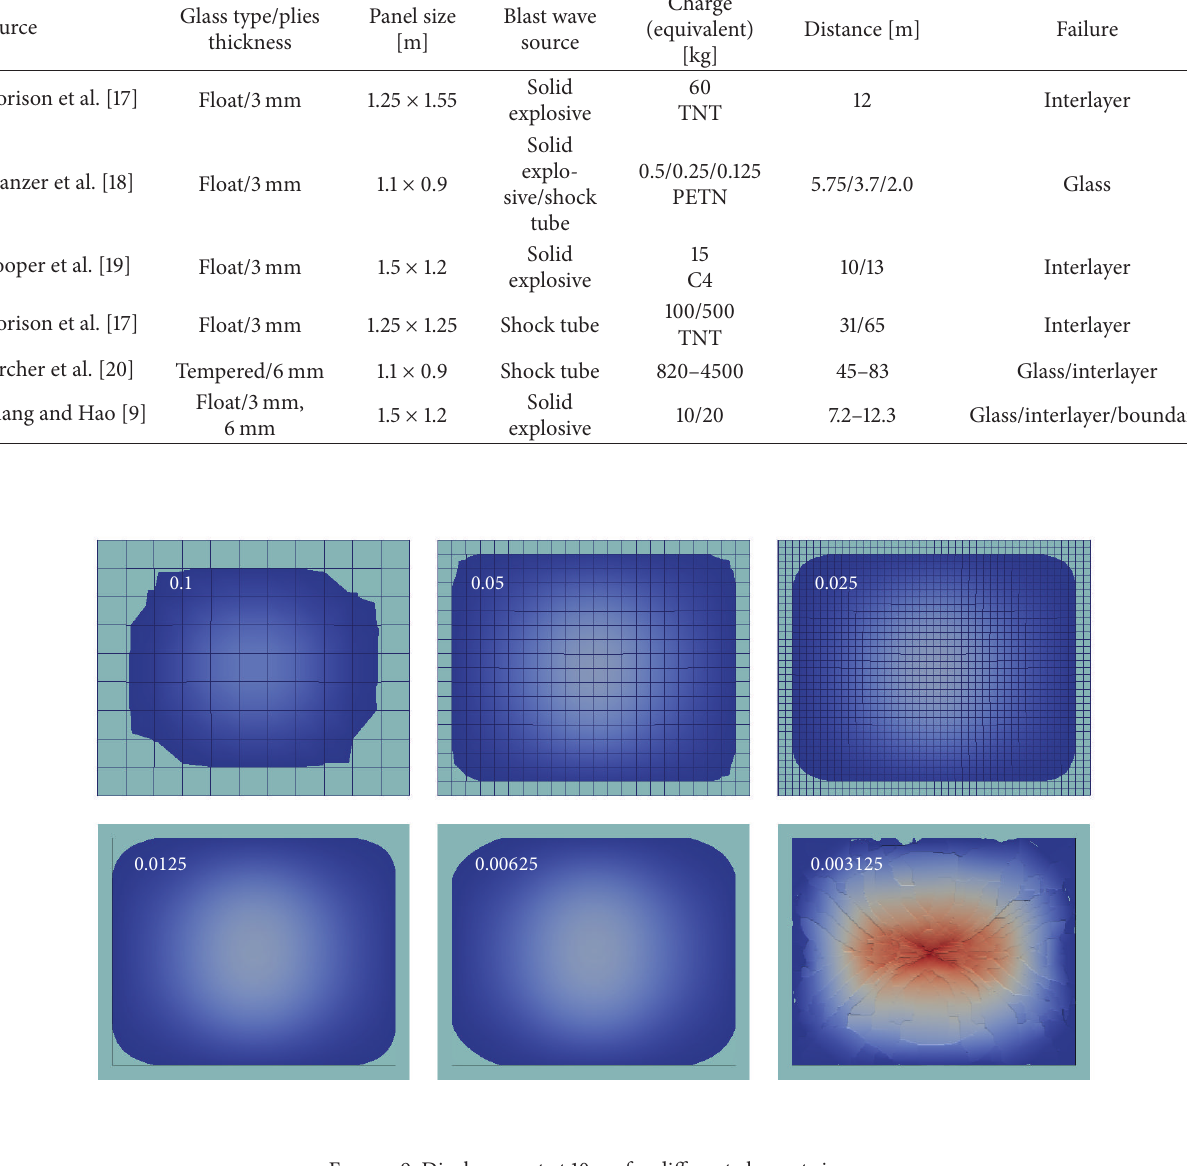
Figure 9: Displacement at 10ms for different element